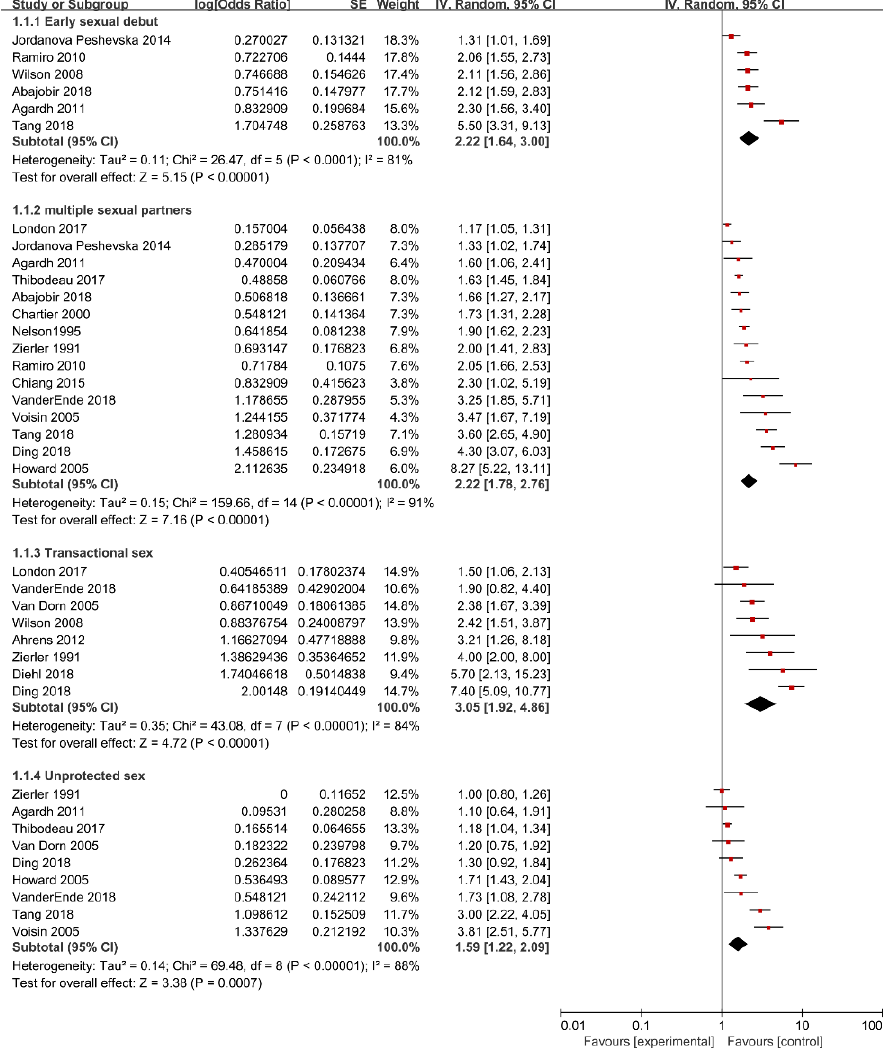
Figure 2. Forest plot for childhood maltreatment and risk of risky sexual behaviors (RSBs).